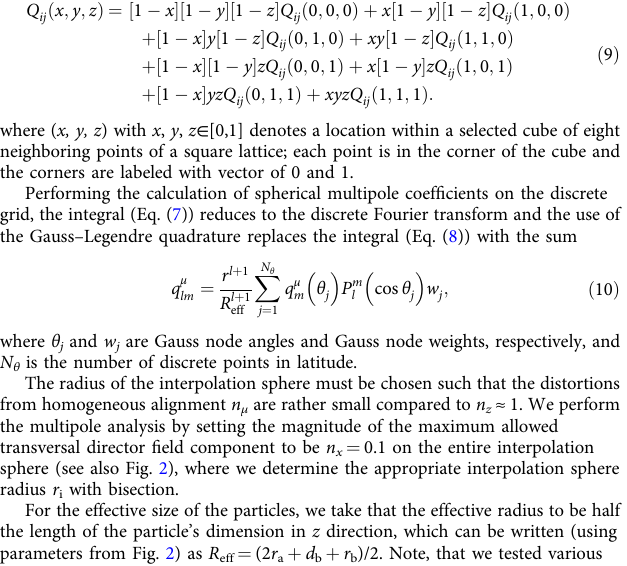
where θ j and w j are Gauss node angles and Gauss node weights, respectively, and N θ is the number of discrete points in latitude. The radius of the interpolation sphere must be chosen such that the distortions from homogeneous alignment n μ are rather small compared to n z ≈ 1. We perform the multipole analysis by setting the magnitude of the maximum allowed transversal director fi eld component to be n x = 0.1 on the entire interpolation sphere (see also Fig. 2), where we determine the appropriate interpolation sphere radius r i with bisection. For the effective size of the particles, we take that the effective radius to be half the length of the particle ’ s dimension in z direction, which can be written (using parameters from Fig. 2) as R eff = (2 r a + d b + r b )/2. Note, that we tested various